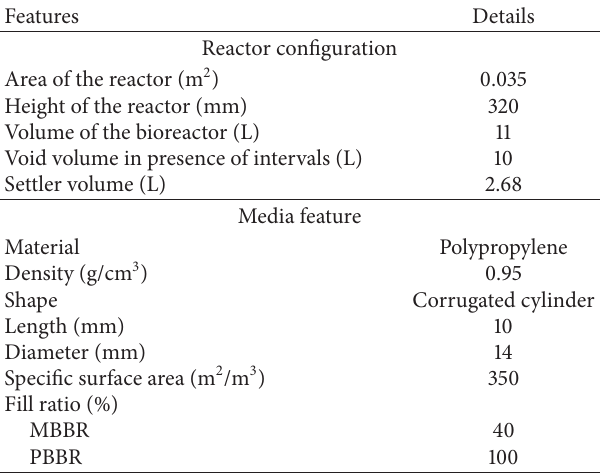
Table 1: The dimensional details and media features of the bench scale system.